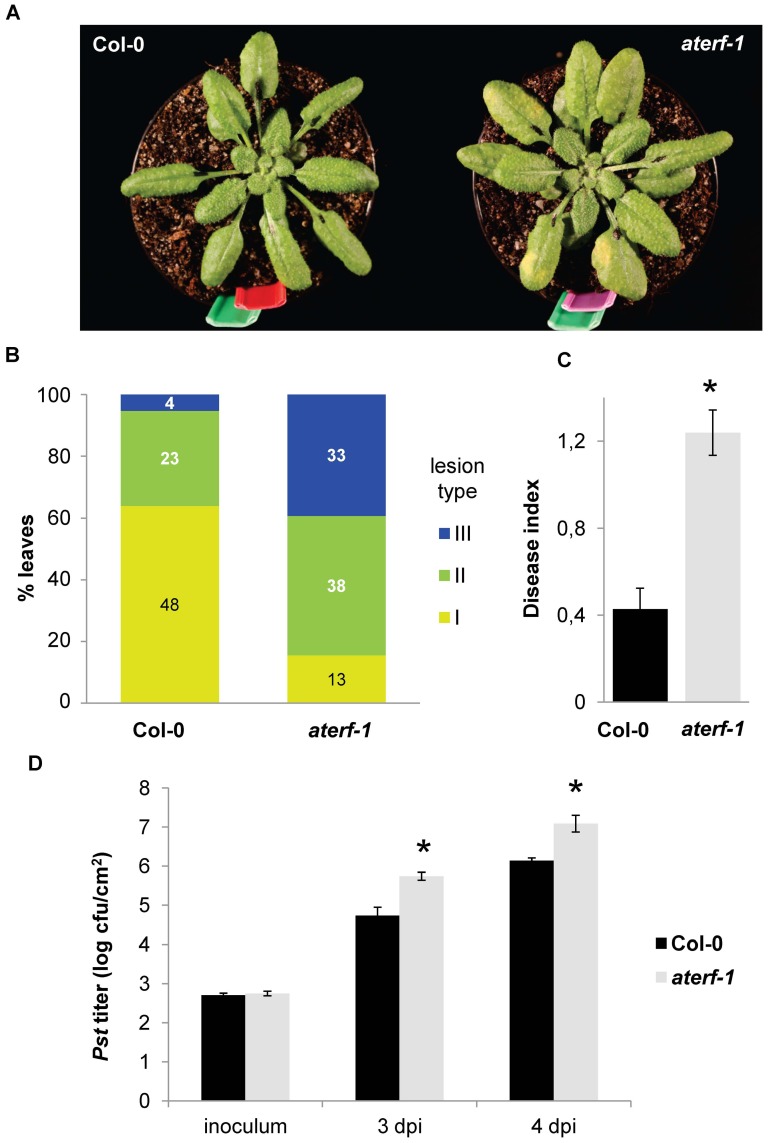

aterf-1 mutant shows increased susceptibility to bacterial infection.(A) Macroscopic symptoms of disease caused by inoculation of Pst strain into the leaves of Col-0 and aterf-1 mutant. (B) Rossette leaves of 5-week-old plants were inoculated with a Pst suspension in series of 8 plants per genotype. Disease symptoms (3 days post-inoculation) were rated on 75–88 leaves/genotype comparing leaves of similar developmental state. The following disease severity classes were established: I, 0–10% of leaf surface as a chlorotic lesion, II, 10–50% of leaf surface, and III, >50% of leaf surface. The percentage of leaves falling in each category is represented with the number of scored leaves inside the bars (C) Disease Index (DI) was calculated for each genotype according to the formula DI = (0n
1+1n
2+2n
3)/N
t where n
1–n
3 is the number of leaves in the I, II or III classes and N
t is the total number of leaves collected from one plant. Asterisk indicates significant differences respect to the wild-type genotype with a p = 3.15×10−6 (t-test) (D) Bacterial titre in Pst-inoculated leaves at 3 and 4days post-inoculation (dpi). Bars represent the average cfu/cm2 leaf surface and error bars represent SD. Asterisks indicate significant difference between genotypes (p<0.01), which was observed in two independent bioassays.